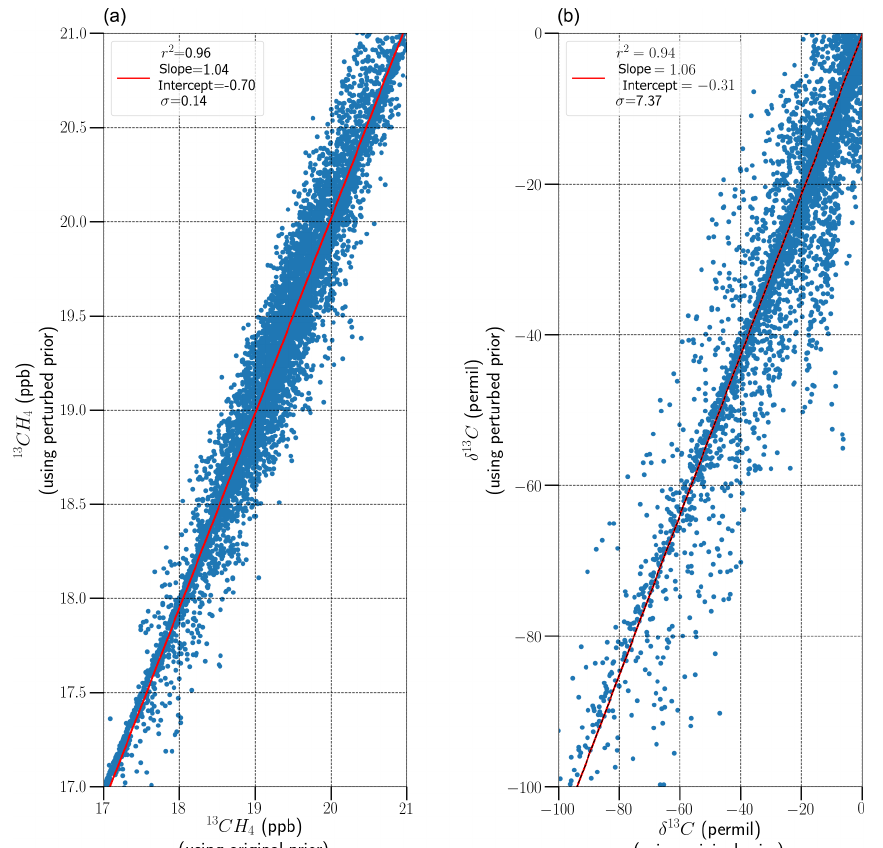
Figure 6. Comparison of retrieved 13 CH 4 (a) and δ 13 C (b) before and after a priori modification by applying a 2K bias on the temperature, where temperature shift is retrieved as a part of the state vector. The red line is a line of best fit, and the statistical characteristics (coefficient of correlation, gradient, intercept and standard deviation of the difference) are indicated in the